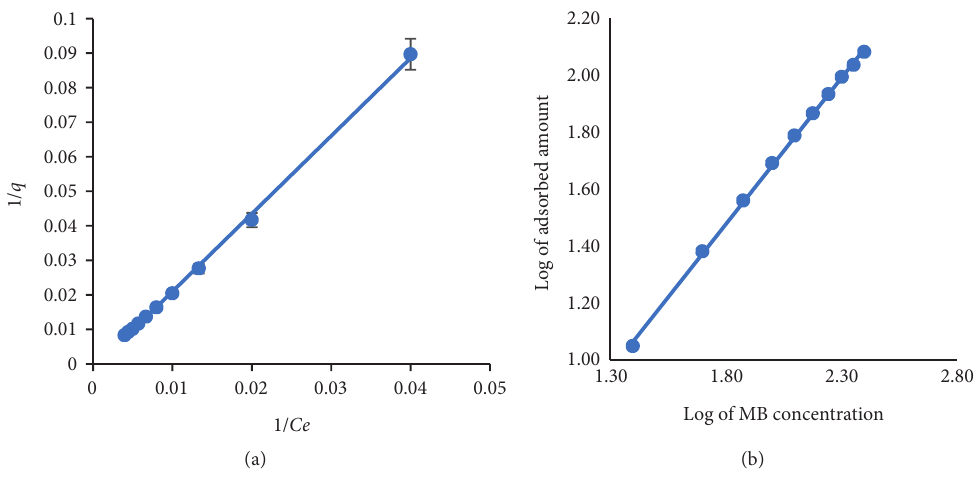
Figure 5: Sorption isotherms: Langmuir (a) and Freundlich (b) for nance seeds at pH 10.